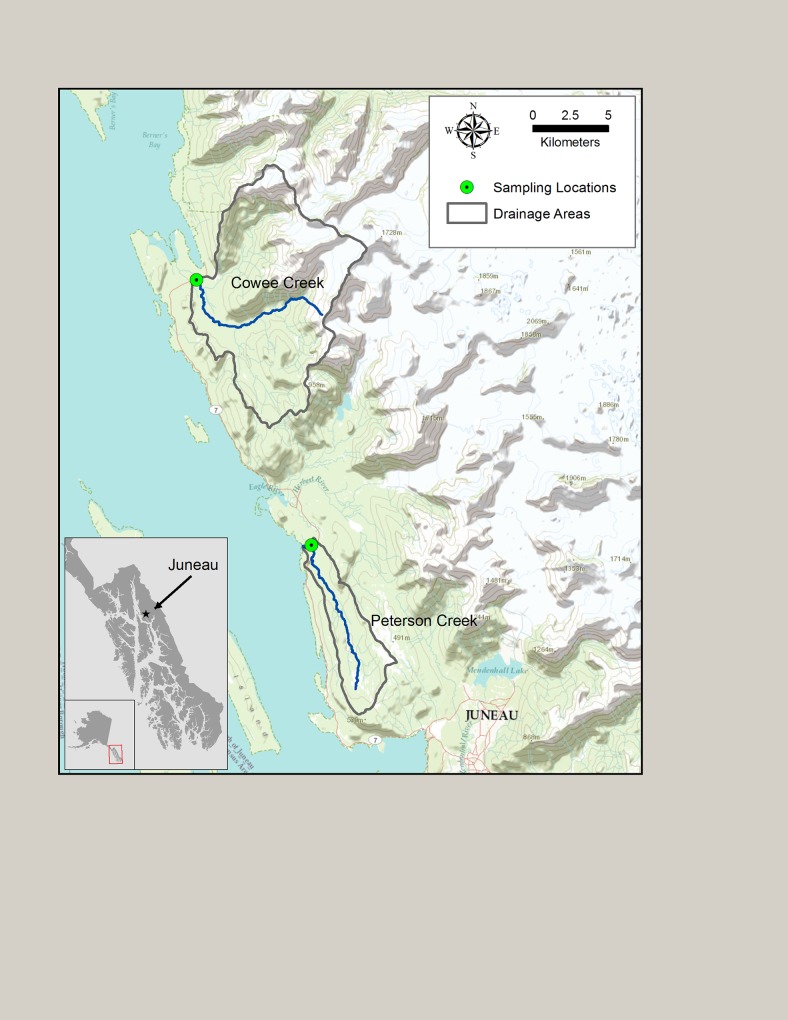
Map of the two study watersheds and sampling sites near Juneau, Alaska.